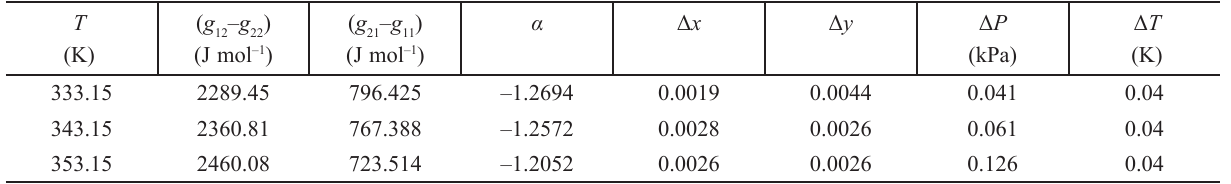
Table 3 – NRTL parameters and average absolute deviations Δ for the 2-propanol + water (2) system T